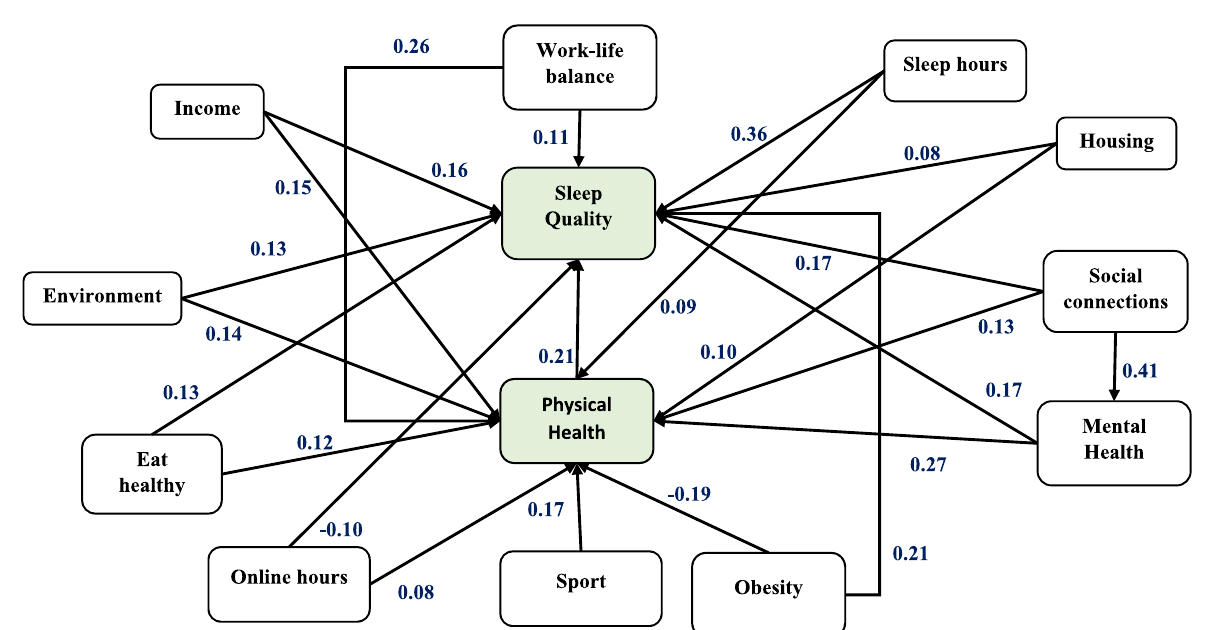
Fig. 1 Path model of sleep quality and well-being factors for working adults